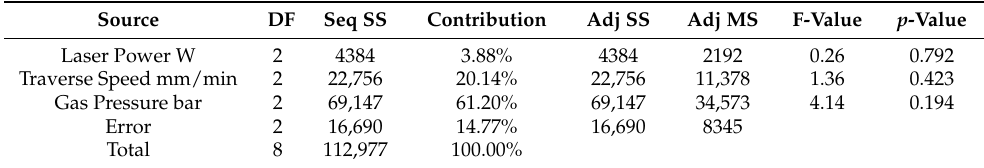
Table 9. ANOVA table for the HAZ response of input cutting parameters of 4 mm thick SPF-UPE.